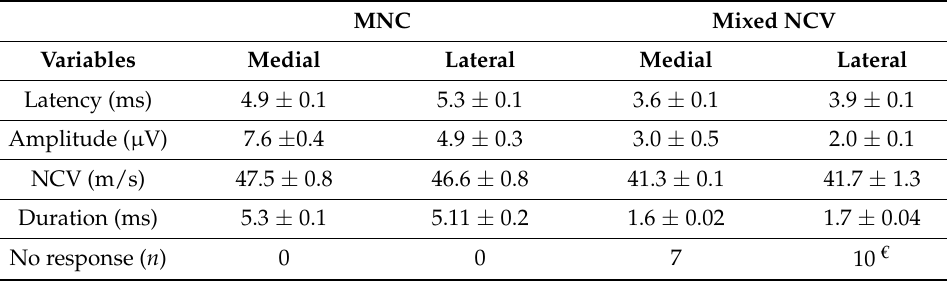
Table 2. Results of the complementary neurophysiological tests.